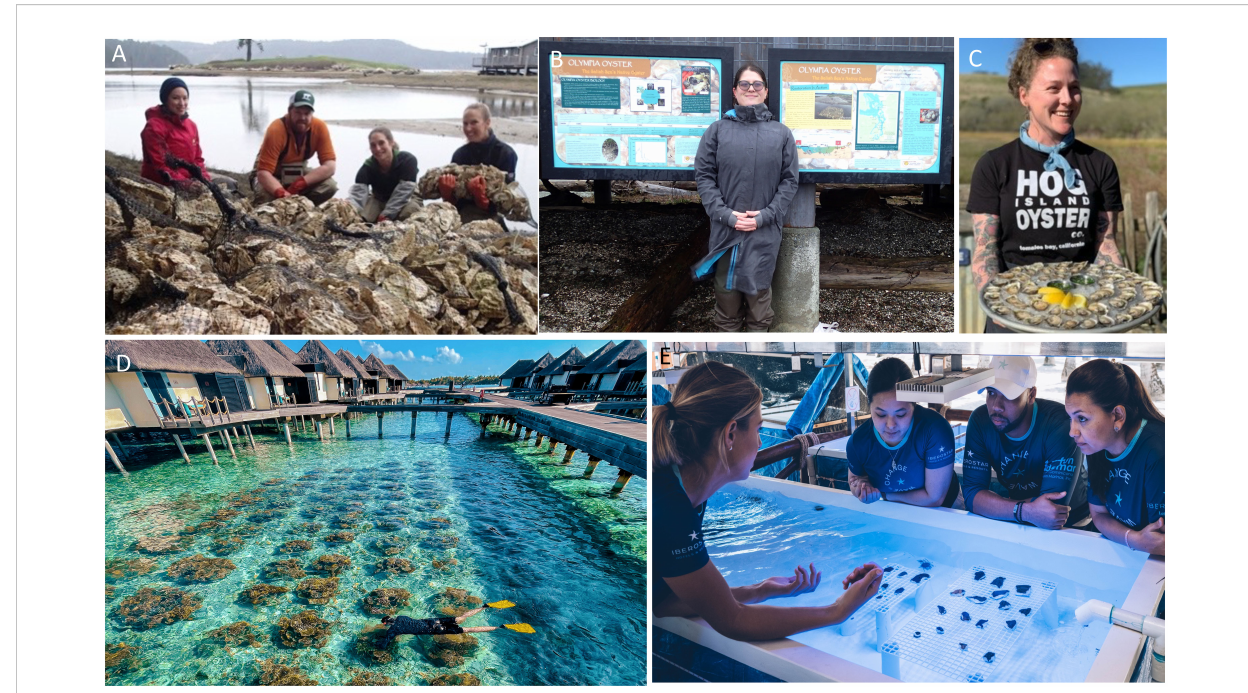
FIGURE 6 Aquaculture projects can restore the stewardship of reefs by Indigenous communities and facilitate novel partnerships. Top Row: Indigenous management and commercial partnerships restore Olympia oyster populations (A) Swinomish Tribal Community members deploy hatchery-raised oysters on Swinomish tidelands. Pictured: Sarah Grossman, James McArdle, Lindy Hunter, and Julie Barber. Photo credit: (J) Barber; (B) Swinomish Tribal community member in front of an educational kiosk about the oyster restoration projects the Tribe leads. Pictured: Jackie Dexter. Photo credit: (J) Barber; (C) Hog Island Oyster Company in California culture and market native oysters as a “ farm-to-table ” culinary experience connected to local restoration efforts. Pictured: Jamie Burgess. Photo Credit: (K) Wilkinson. Bottom Row: Coral restoration led by the tourism industry (D) A biologist from Reefsavers checks outplanted coral frames directly outside of a resort in the Maldives. Pictured : Reefsavers staff, with permission. Photo credit: Reefscapers; (E) Iberostar hotels worked closely with scientists to establish the lab and nursery they use to support coral restoration efforts in the Dominican Republic. Pictured: Macarena Blanco, Megan Morikawa, Alberto Silverio, Johanna Calle. Photo credit: Iberostar Hotels